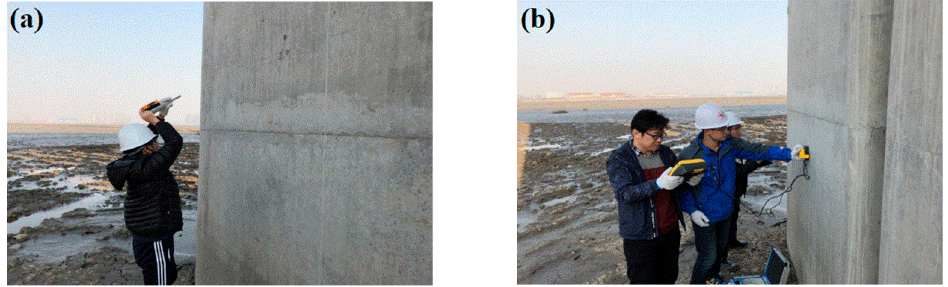
Figure 2. Rebound strength and cover thickness tests at piers. ( a ) Rebound strength; ( b ) Cover thickness.